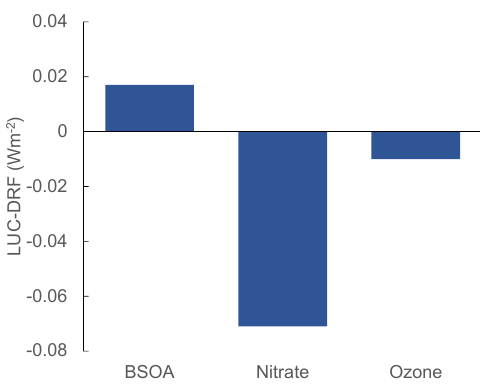
Figure 11. Global annual mean direct radiative forcing associated with anthropogenic land use change (LUC-DRF) from 1850 to